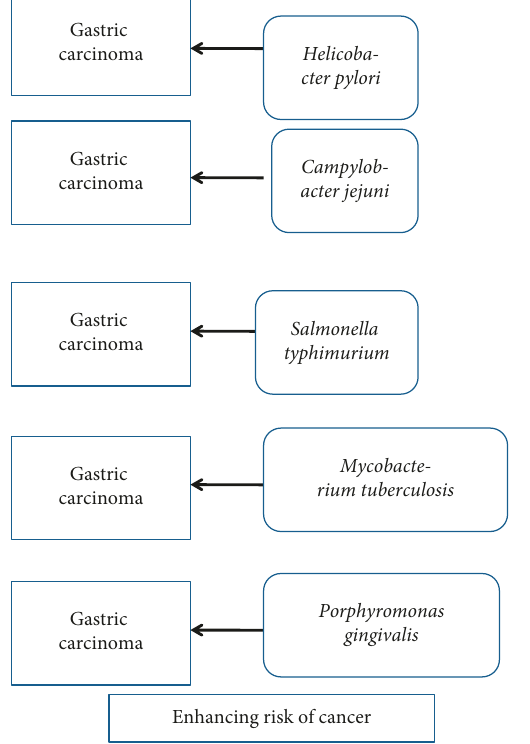
Figure 1: Bacteria involved in causing different types of